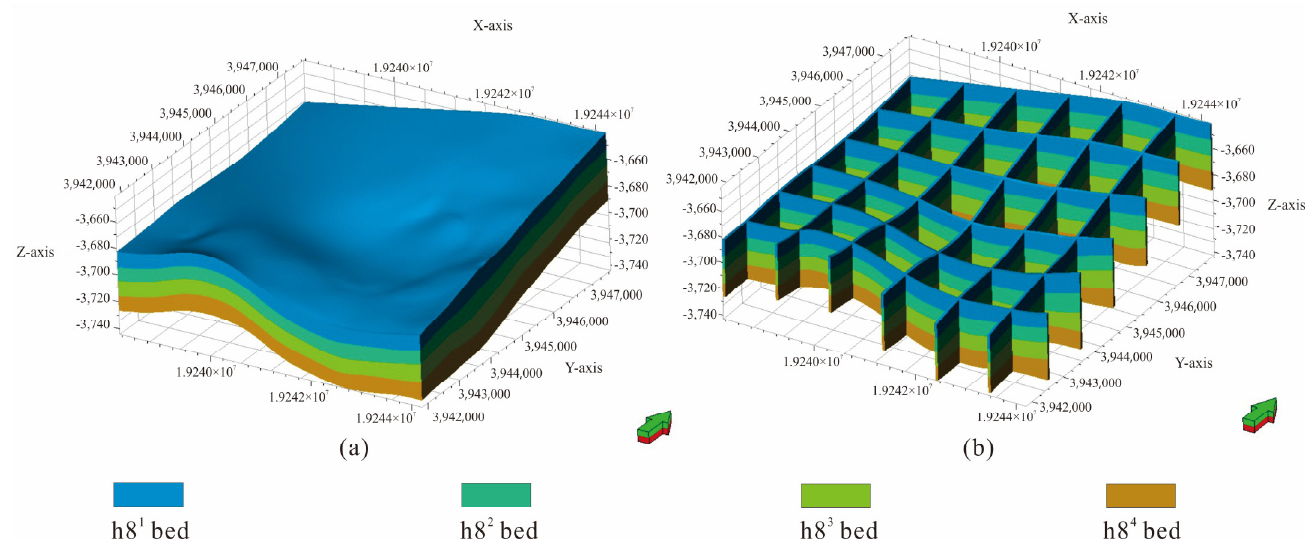
Figure 5. Simulation results of geological structure model in the study area: ( a ) 3D model; ( b ) grid model. Table 1. Simulation parameters of sedimentary microfacies in Ct3 study area in P 2 h 8